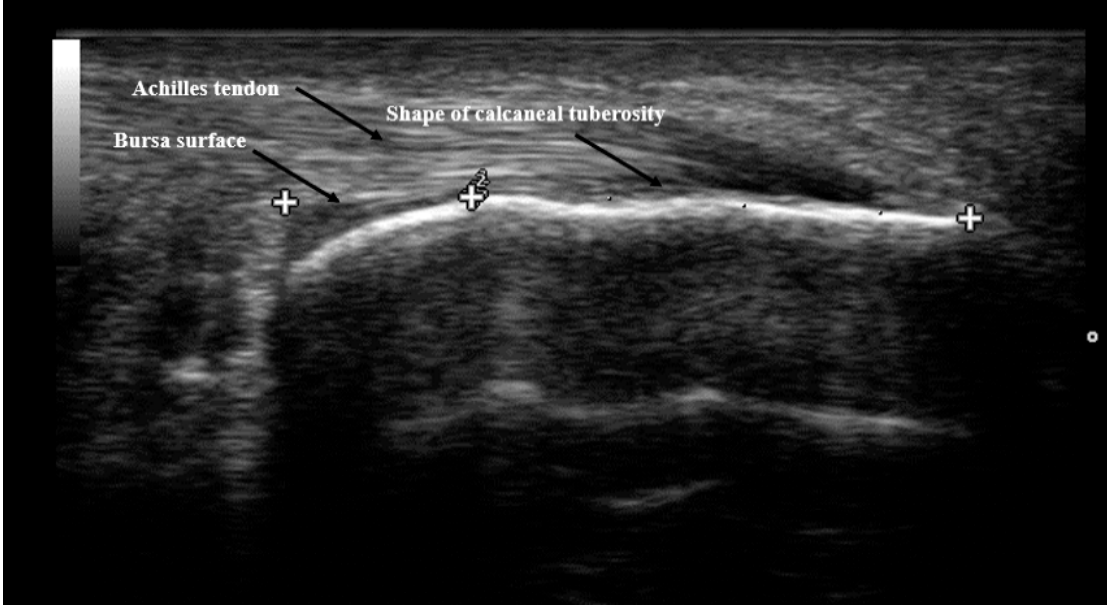
Figure 2. Ultrasonographic image of flat shape of the calcaneal tuberosity.